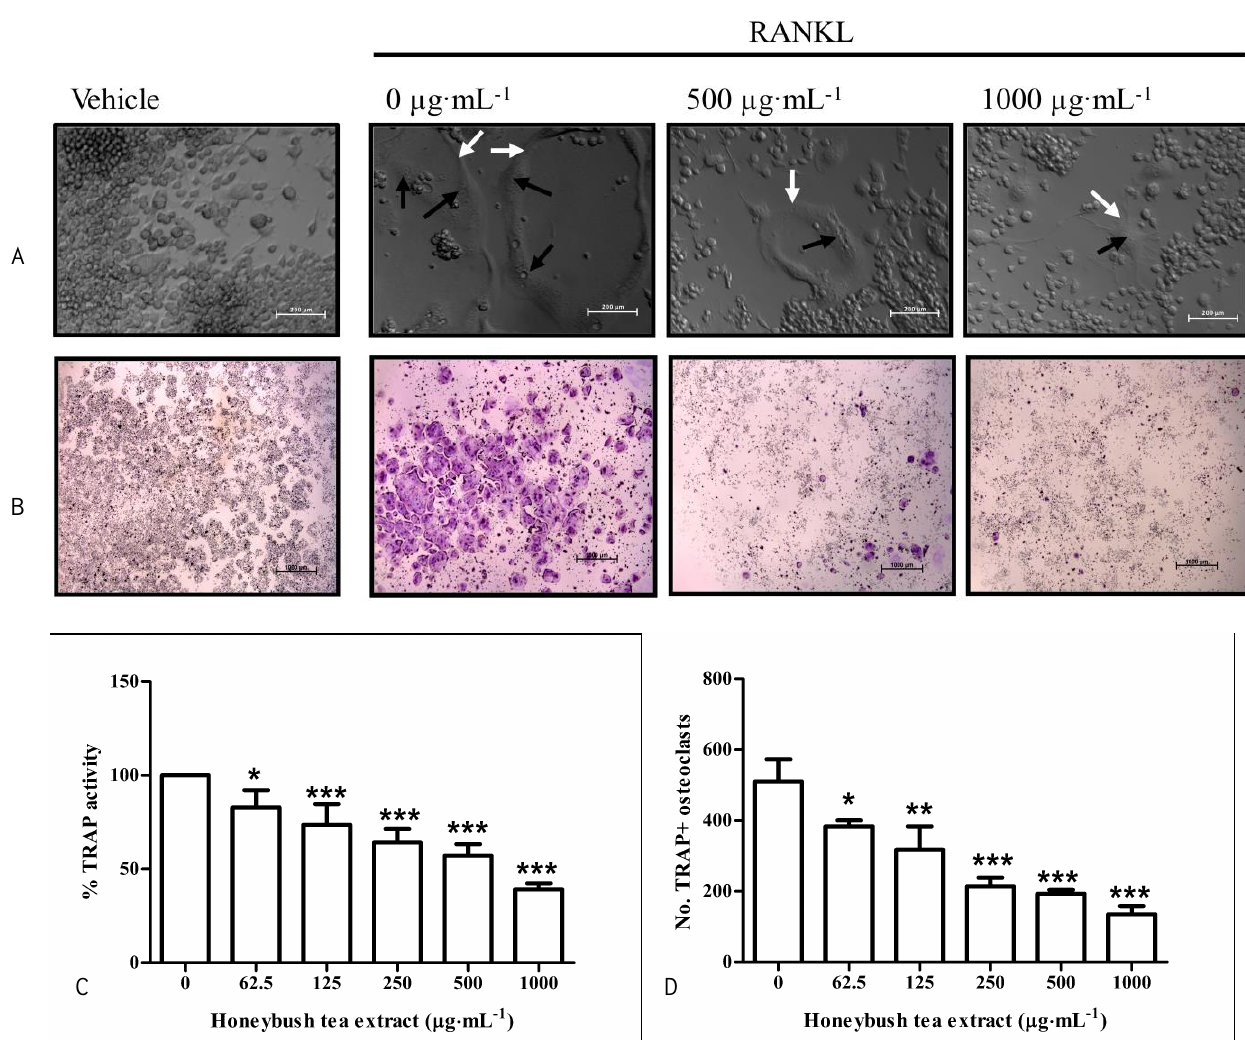
Figure 2. Effect of honeybush tea extract on cell morphology and osteoclast formation. ( A ) PlasDIC images. Osteoclast boundaries are indicated with white arrows while nuclei are indicated with black arrows. Scale bar = 200 µm. ( B ) Photomicrographs of osteoclasts in culture wells. Osteoclasts stain purple in the presence of TRAP. Scale bar = 1000 µm. ( C ) TRAP+ cells with three or more nuclei were counted as mature osteoclasts in each well. ( D ) TRAP activity was quantified and represented as a percentage relative to the